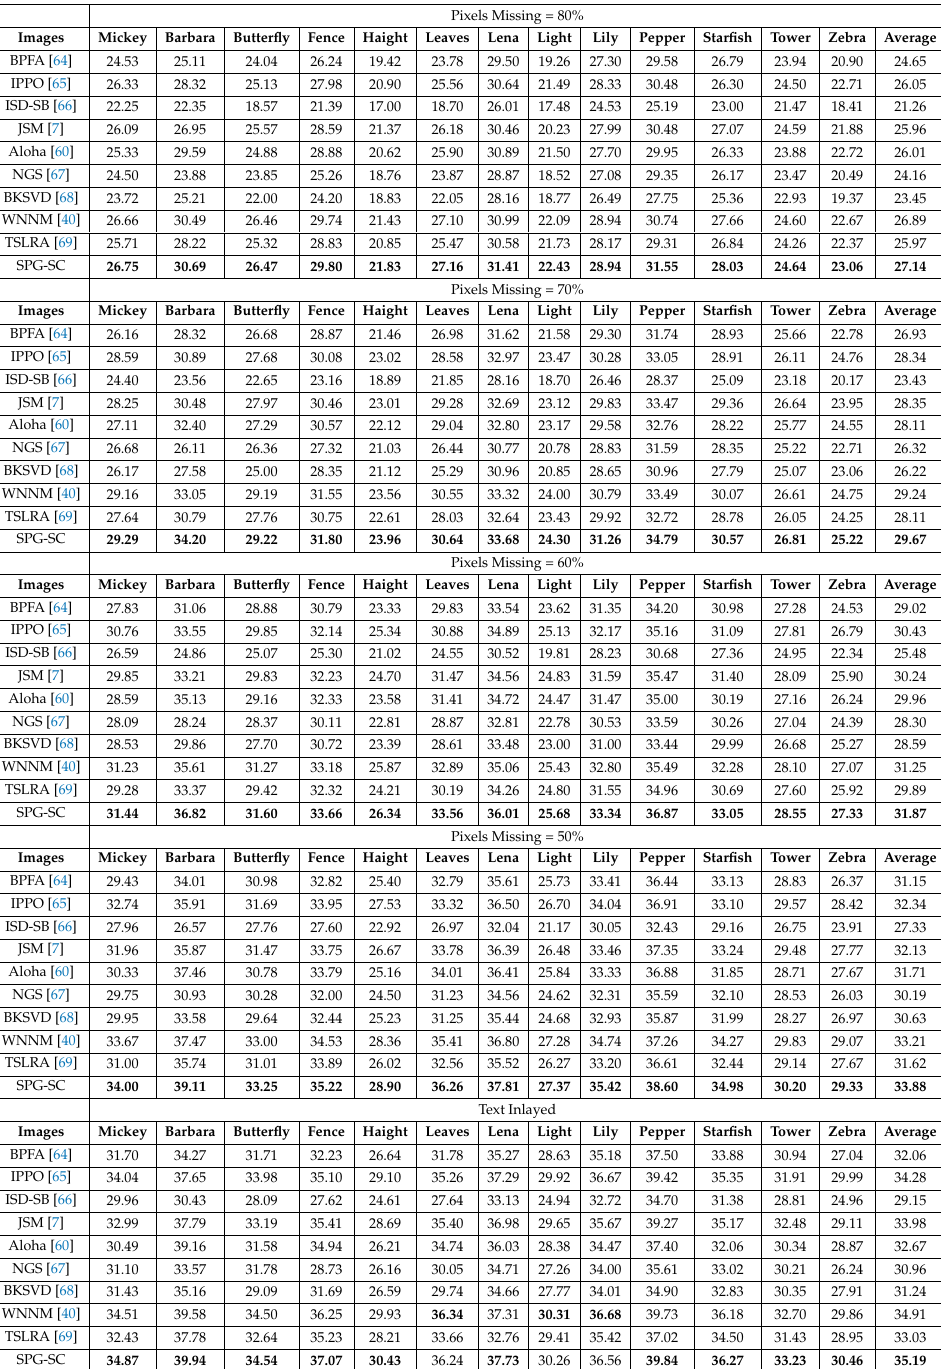
Table 1. PSNR (dB) comparison of BPFA [64], IPPO [65], ISD-SB [66], JSM [7], Aloha [60], NGS [67], BKSVD [68], WNNM [40], TSLRA [69] and SPG-SC for image